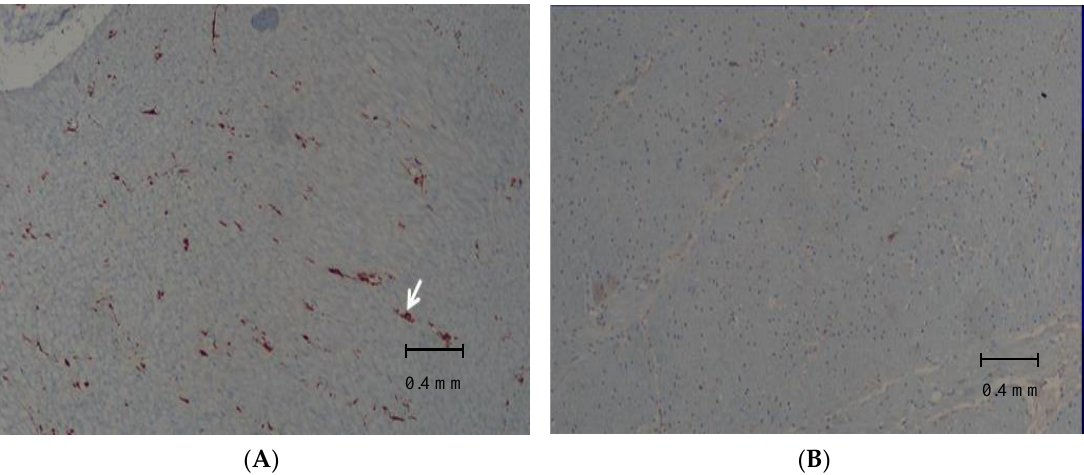
Figure 2. Antral interstitial cells of Cajal (ICC) in a control ( A ) compared to a gastroparetic patient ( B ) (20 × ). White arrows indicate c-Kit positive cells. Thirty-eight diabetics (66% F, n = 25) provided adequately sized antral biopsies. In the antrum, 40% of females had depletion of ICC (by definition, < 10 cells / HPF), compared to 38% in males. The scale line represents 0.4 mm. Table 1. Results of ICC status based on gender and gastric region in diabetic gastroparetic patients who received gastric electrical stimulation systems and pyloroplasty for their severe gastroparesis (GP) symptoms.